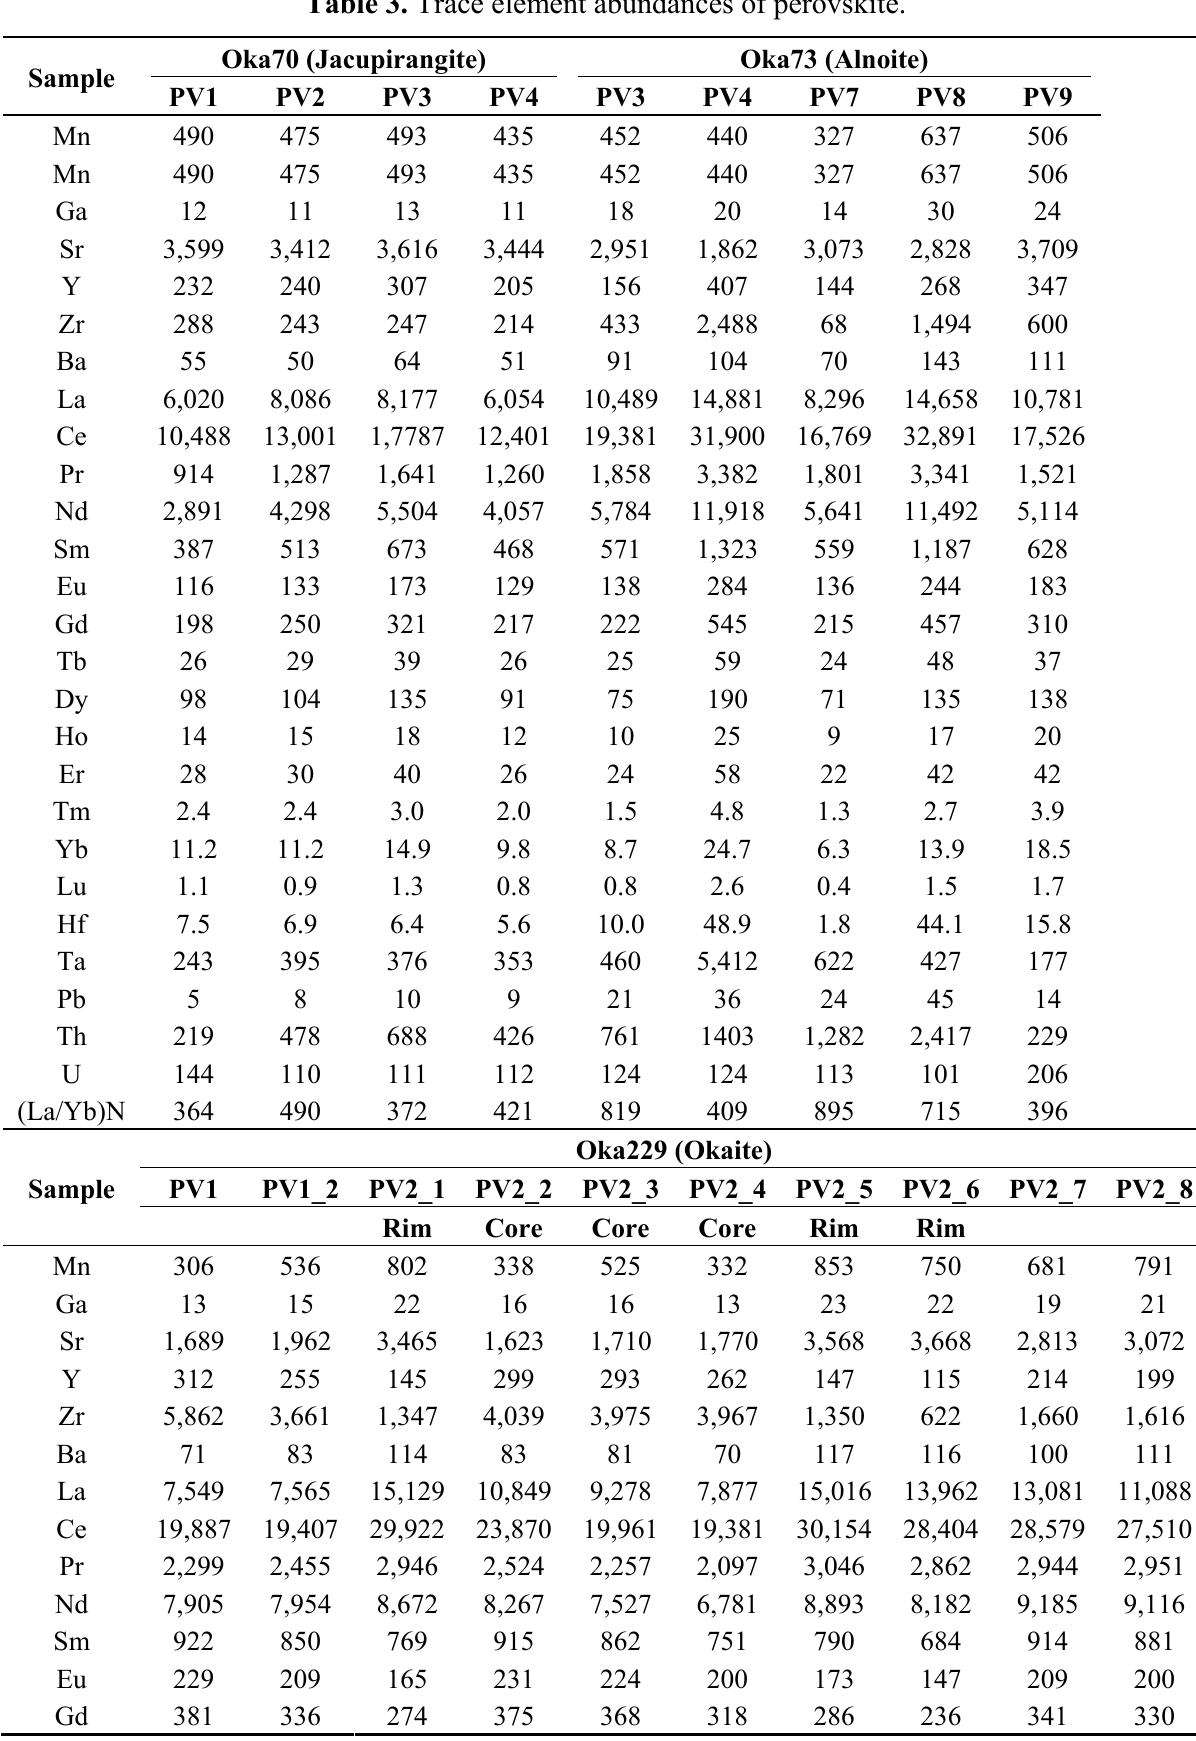
Table 3. Trace element abundances of